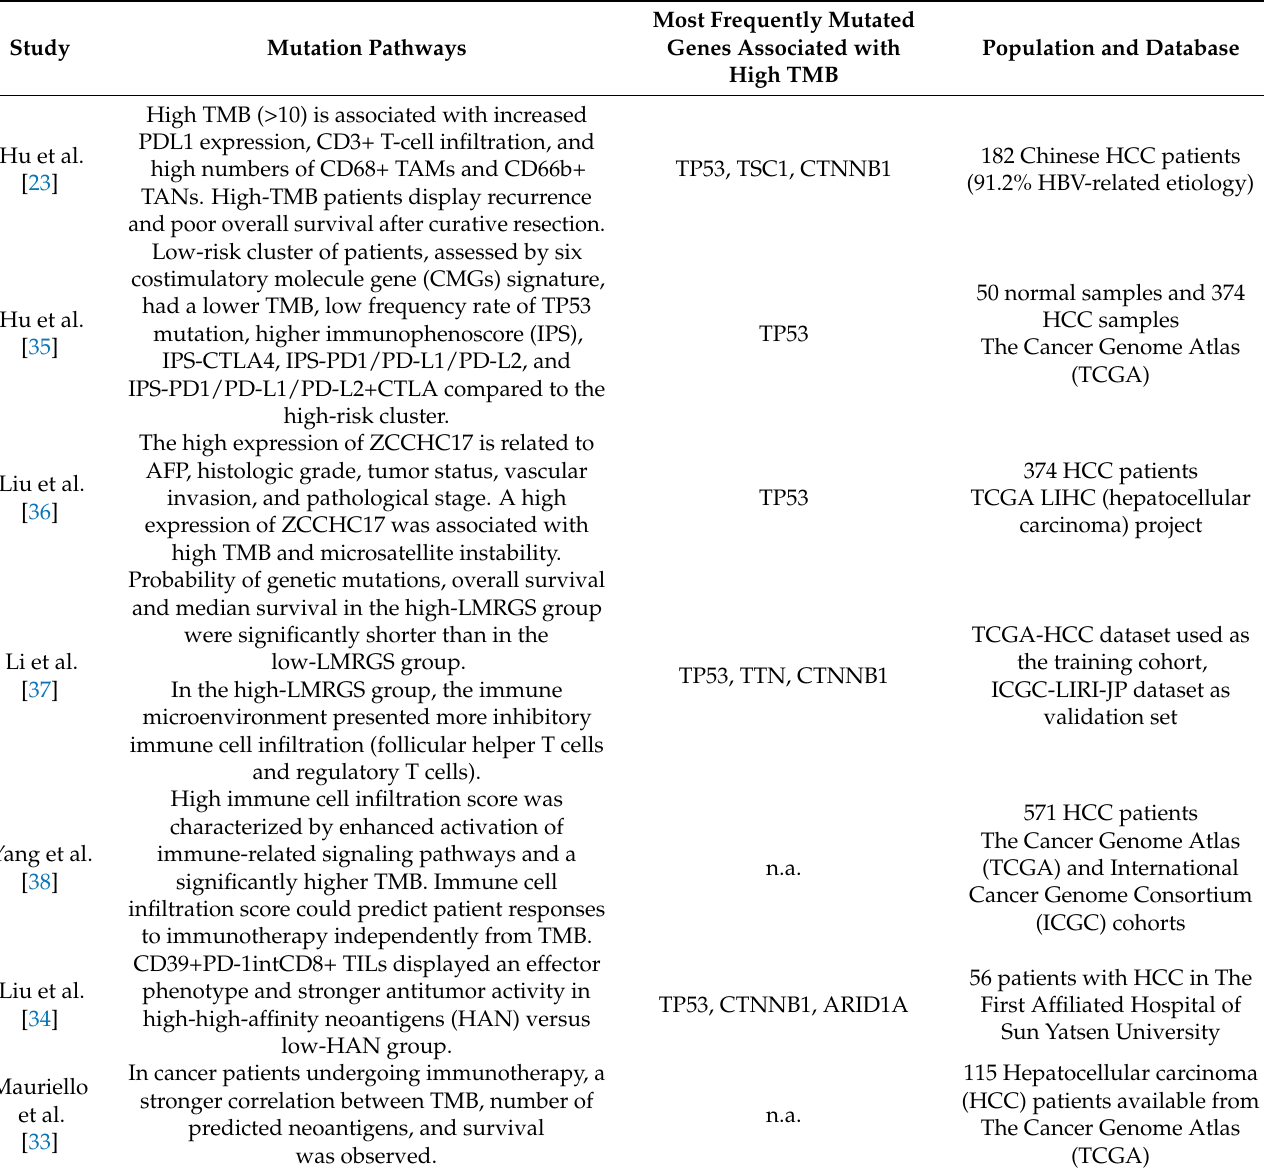
Table 1. Most representative studies investigating the correlation between TMB and HCC outcome. The most frequently mutated genes related to high TMB are reported